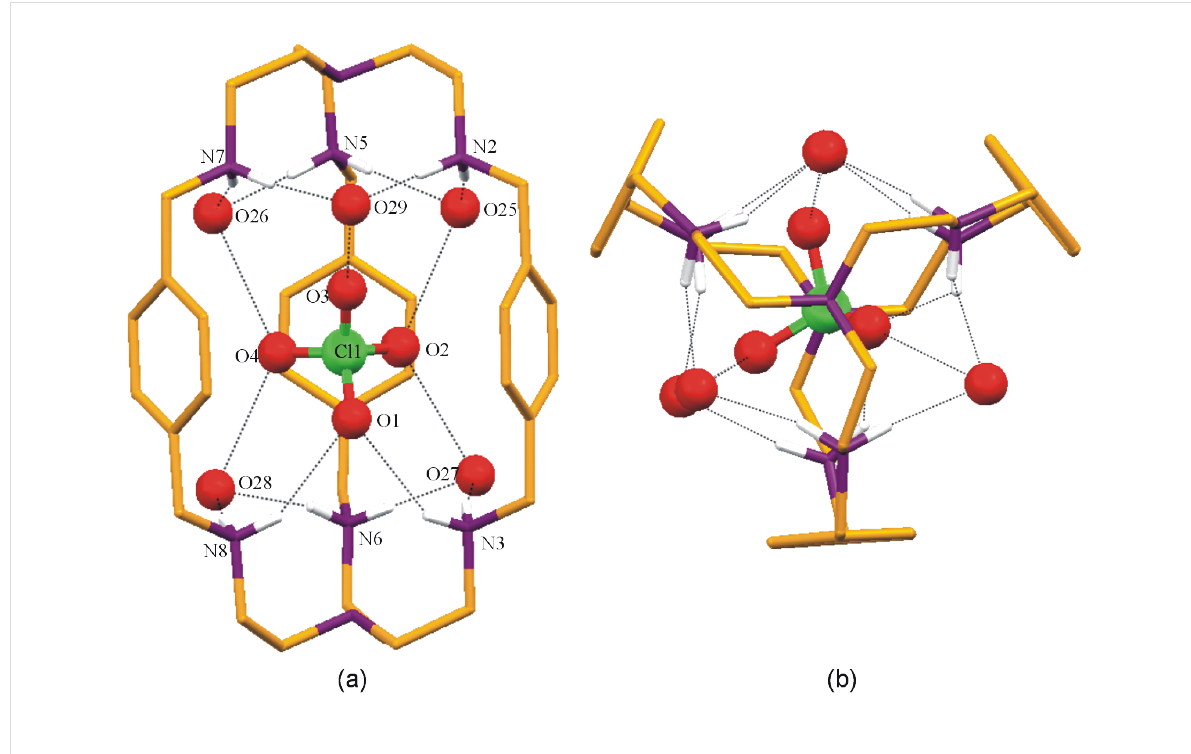
Figure 3: (a) Mercury diagram depicting the interactions of the encapsulated ClO 4− within the [H 6 L 1 ] 6+ and the surrounding water molecules. (b) Mercury diagram depicting the interactions of the encapsulated ClO 4− within the hexaprotonated tere-cryptand moiety and the surrounding water molecules viewed down the bridgehead nitrogen atoms. Hydrogen atoms other than acidic, external perchlorates and lattice water molecules are omitted for clarity.